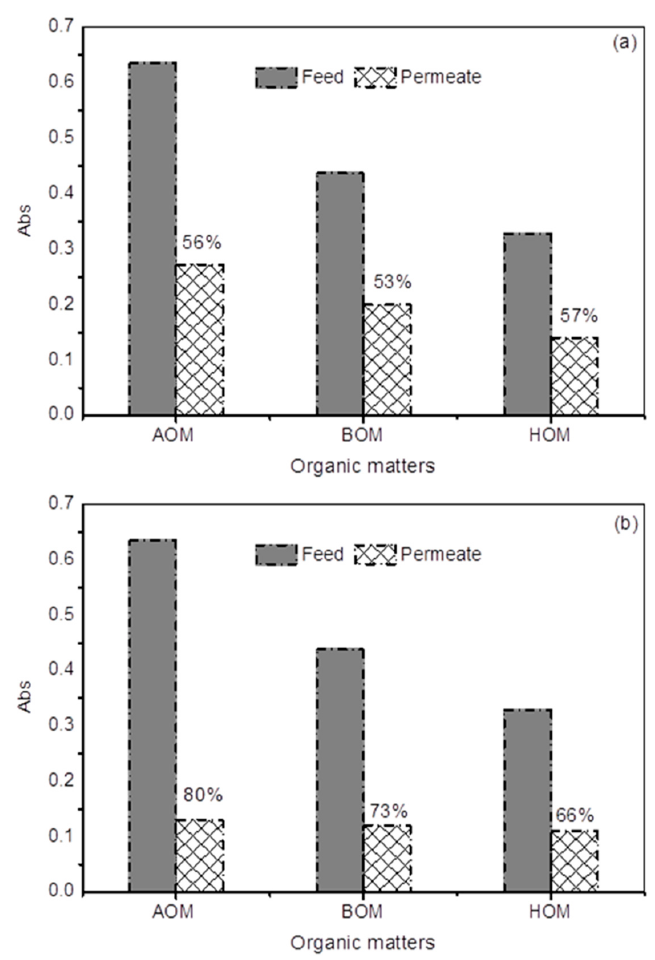
Figure 4. TEP removal as a function of absorbance of ( a ) 50 kDa and ( b ) 5 kDa for all organic matters.